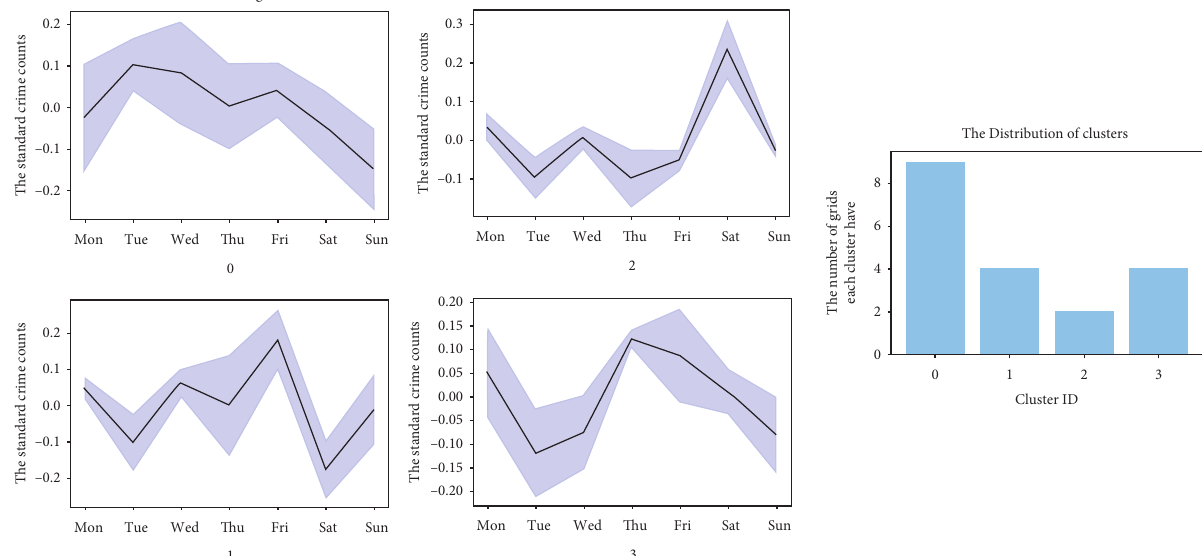
Figure 7: The burglary in San Francisco trends in the average week in 2018 and the distribution of clusters. The line charts are the weekly trends of burglary in San Francisco in 2018. The bar chart is the distribution of the clusters.